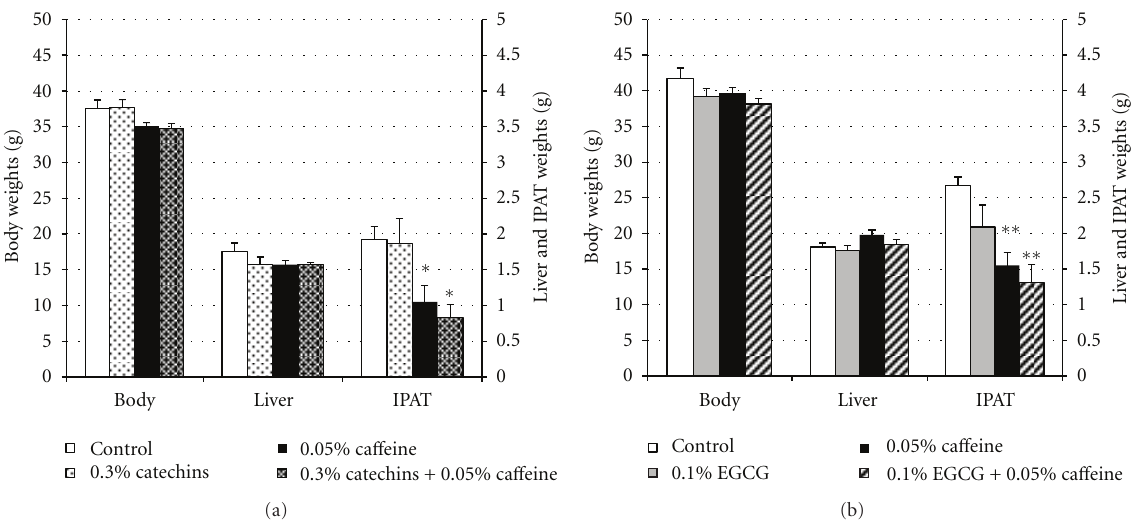
Figure 1: E ff ects of catechins, EGCG, and ca ff eine on weights of body, liver, and intraperitoneal adipose tissues in mice. (a) Weights of body, liver, and intraperitoneal adipose tissues (IPAT) in mice fed the diets containing 0.3% catechins, 0.05% ca ff eine, 0.3% catechins + 0.05% ca ff eine for 4 weeks. (b) Weights of body, liver, and IPAT in mice fed the diets containing 0.1% EGCG, 0.05% ca ff eine, 0.1% EGCG + 0.05% ca ff eine for 4 weeks. The means and SE for 10 mice are plotted. ∗ , ∗∗ Significant di ff erence compared with the control ( ∗ P < 0 . 05, ∗∗ P < 0 .